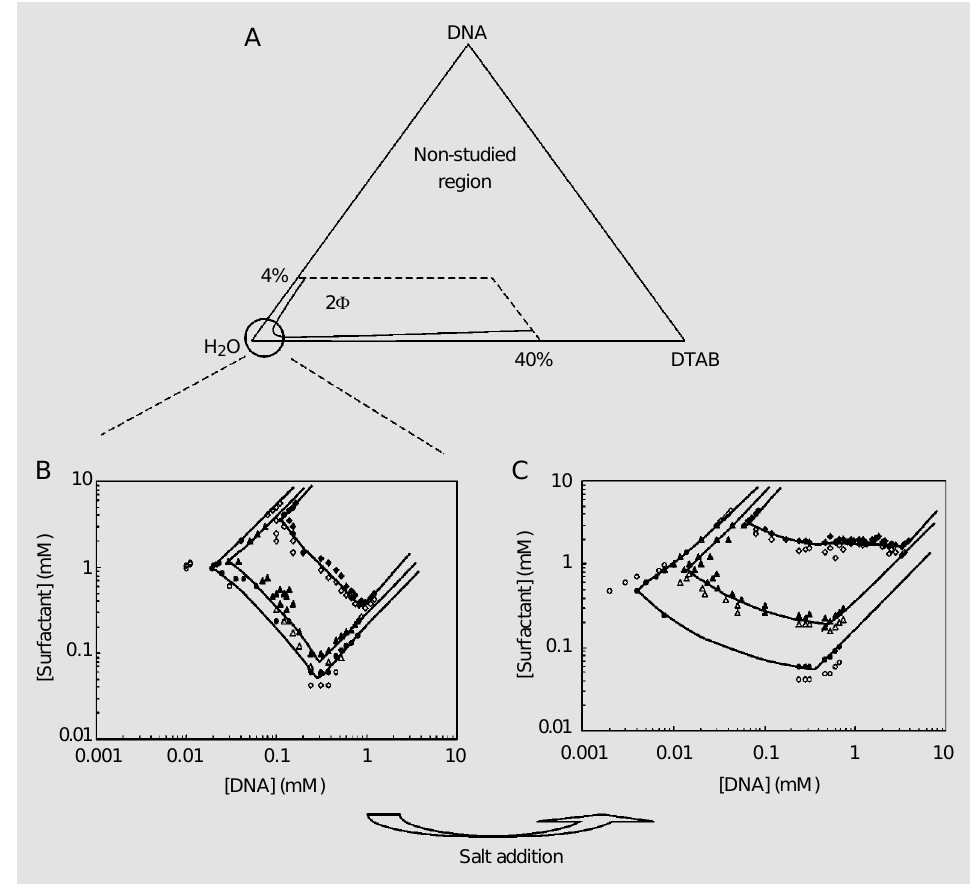
Figure 2. A , Schematic represen- tation of the isothermal pseudo- ternary phase diagram for the DNA-dodecyltrimethylammo- nium bromide (DTAB)-water sys- tem. There is a phase separation into two phases in almost the entire region considered. B , Ex- panded view of the water cor- ner of the system (diamond) in- cluding the DNA-tetradecyltri- methylammonium bromide (TTAB)-water (triangle) and DNA- cetyltrimethylammonium bro- mide (CTAB)-water (circle) sys- tems for comparison. Open symbols refer to the clear one- phase solutions and filled sym- bols to two-phase samples. C , Phase map for the same three systems in the presence of 0.1 M NaBr. T = 25 (cid:1) C. Redrawn from Ref. 11, with